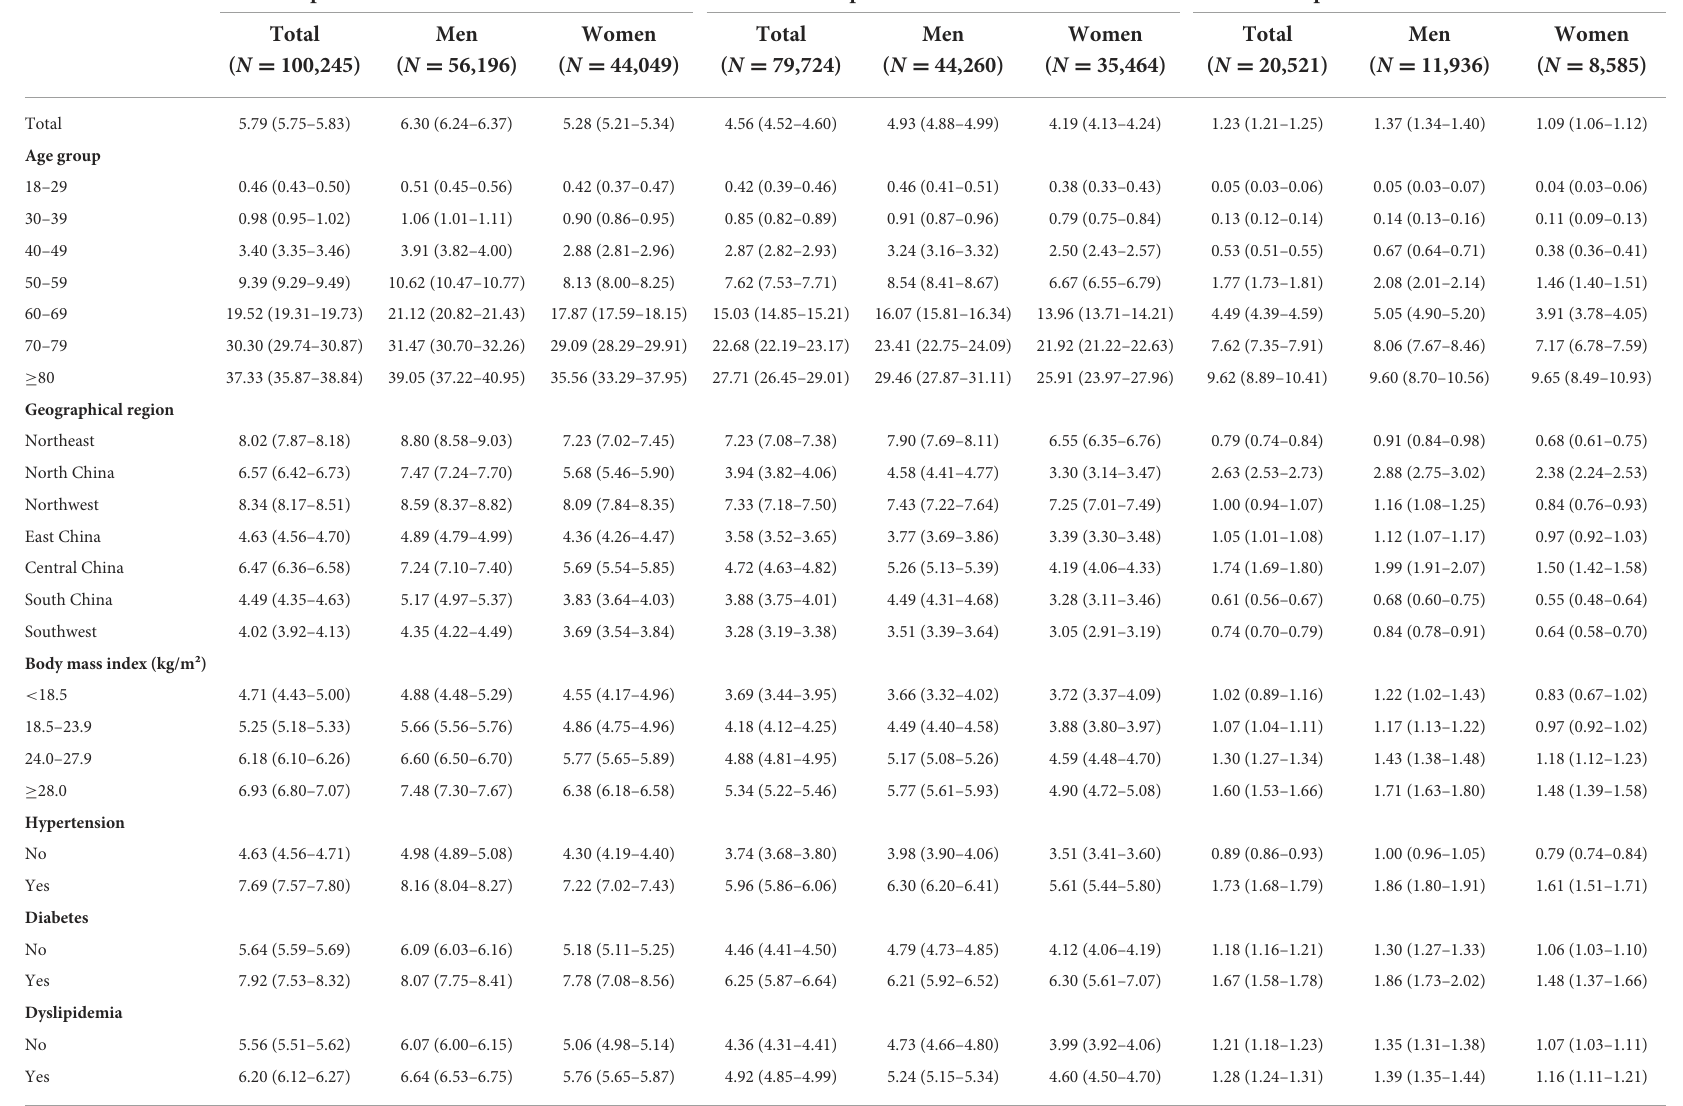
TABLE 2 The age- and sex-standardized prevalence of brain infarcts in the Chinese health examination population in 2018.